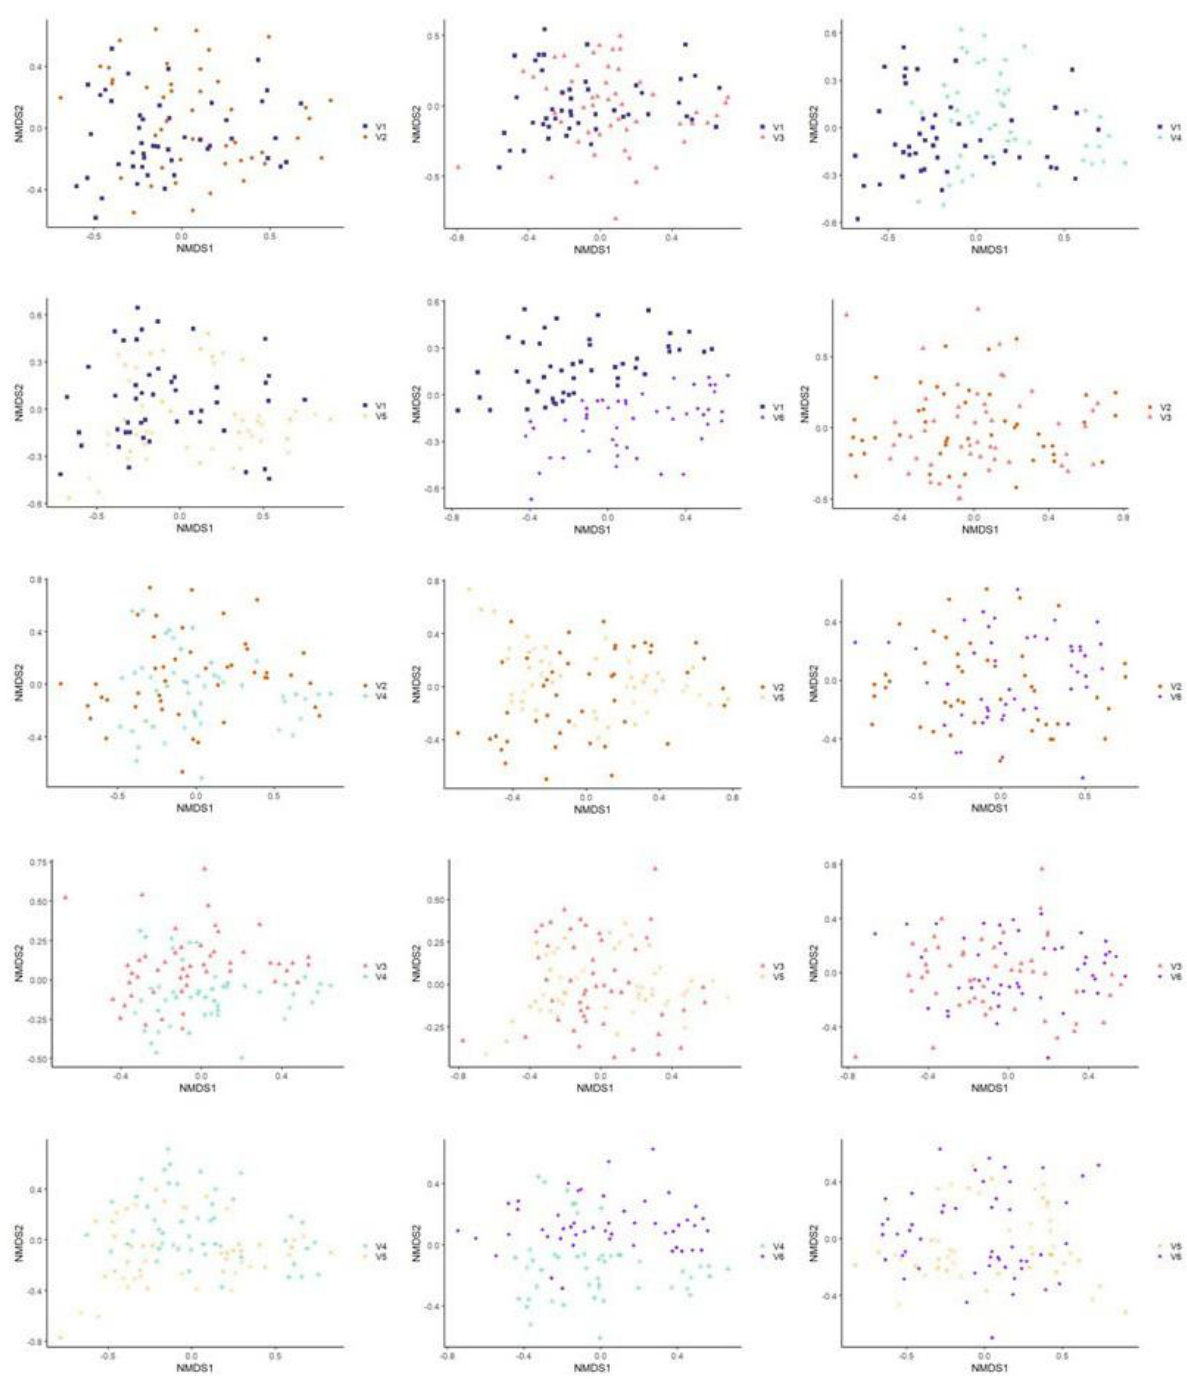
Figure 2. Non-Metric Multidimensional Scaling Graphs (NMDS) using Bray–Curtis index illustrating sample microbiome beta-diversity according to visit and paired two by two. Blue square: Visit one; Orange circle: Visit two; Pink triangle: Visit three; Turquoise star: Visit four; Yellow x: Visit five; Purple diamond: Visit six.